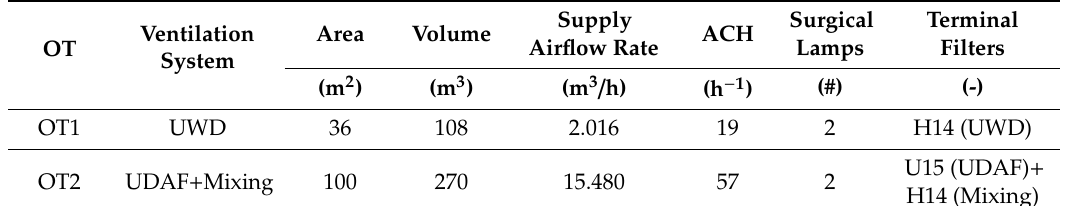
Table 1. Technical data of the evaluated OTs.